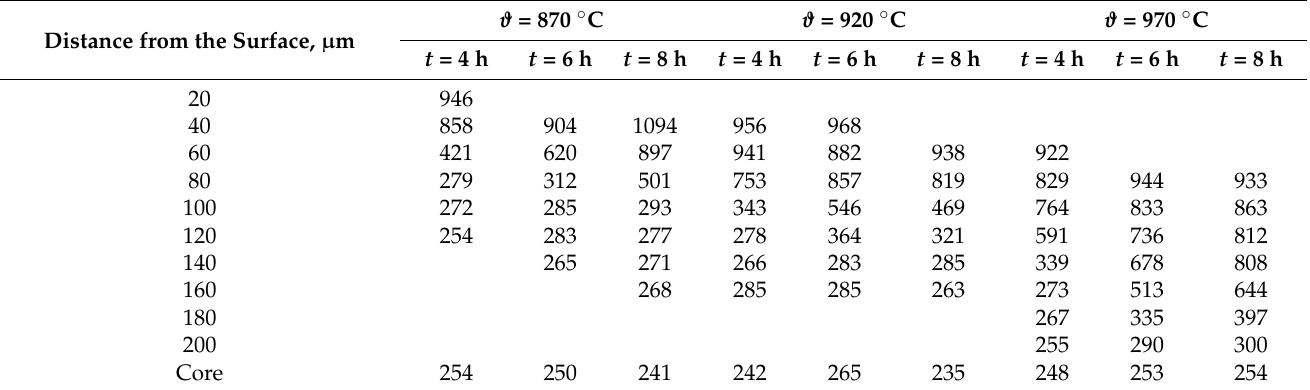
Table 4. Cross-sectional microhardness of the transition zone on boronized C70W2 steel, HV 0.1. Distance from the Surface, µ